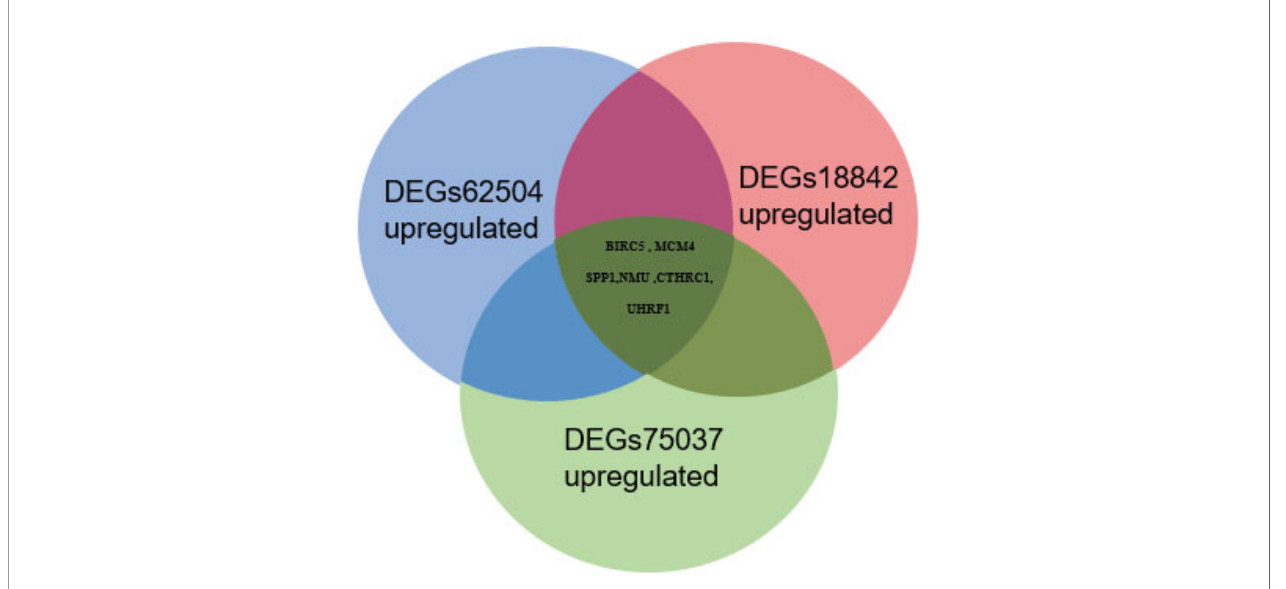
FIGURE 4 | Venn diagram of signi fi cantly upregulated DEGs from the GSE62504, GSE75037, and GSE18842